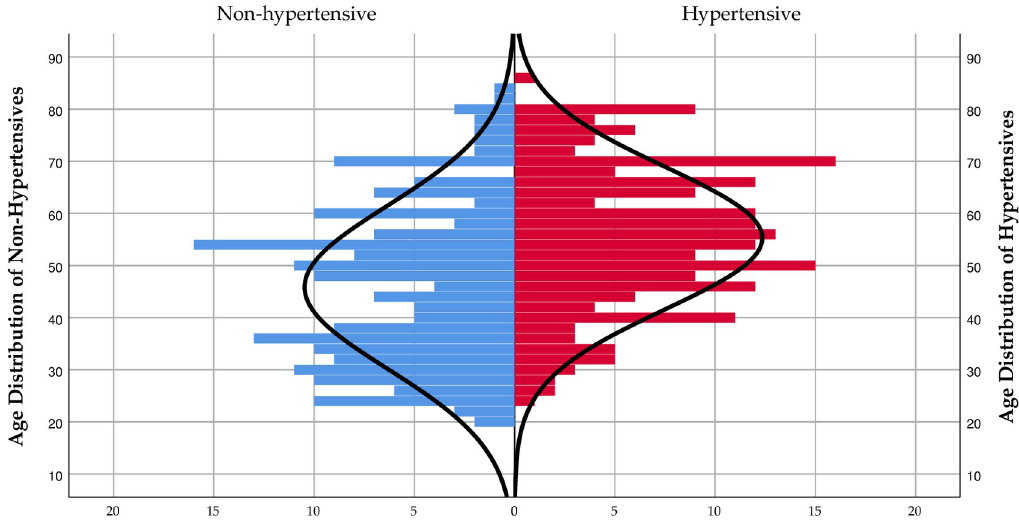
Fig 1. Age distribution population pyramid over hypertension among residents of Nyive.